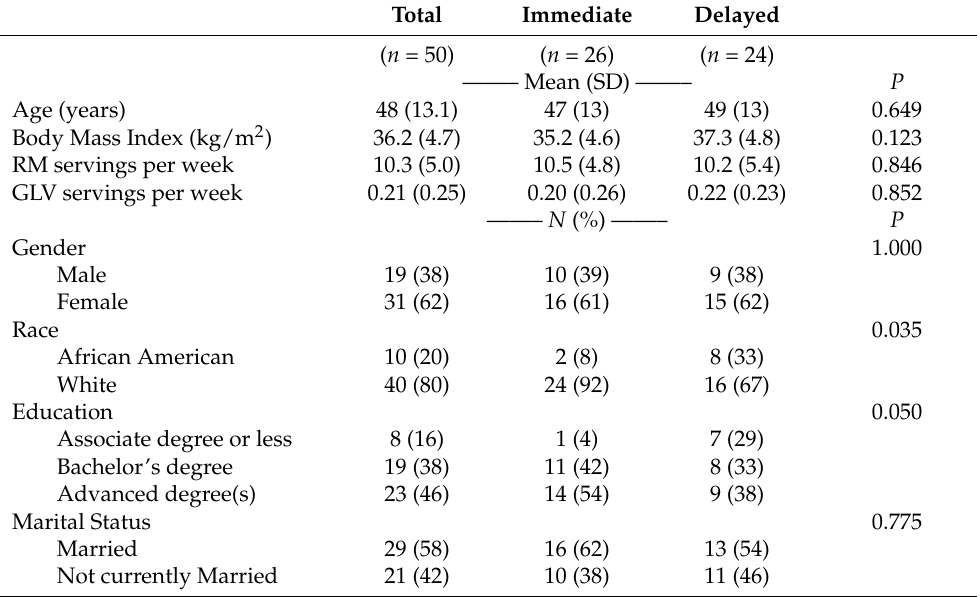
Table 1. Characteristics of participants in a randomized controlled crossover high green leafy vegetable dietary